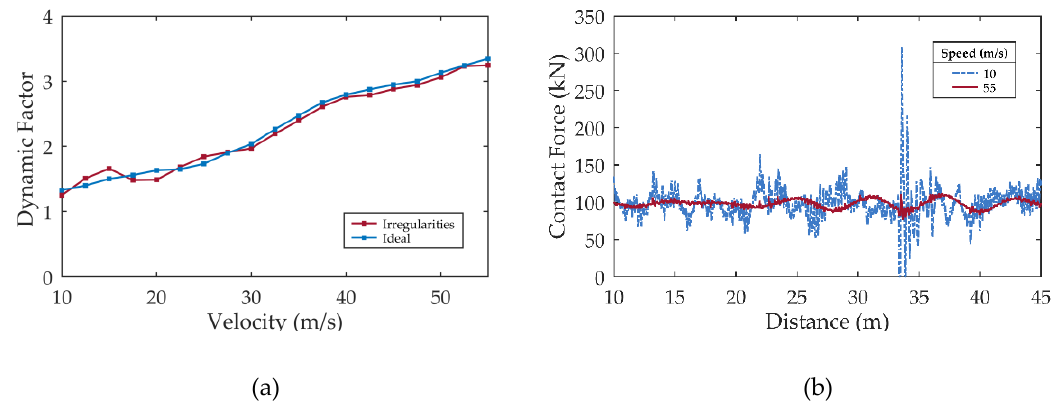
Figure 5. Multibody responses: ( a ) Dynamic factors for two cases: track with no irregularities and with irregularities; ( b ) contact forces for minimum and maximum